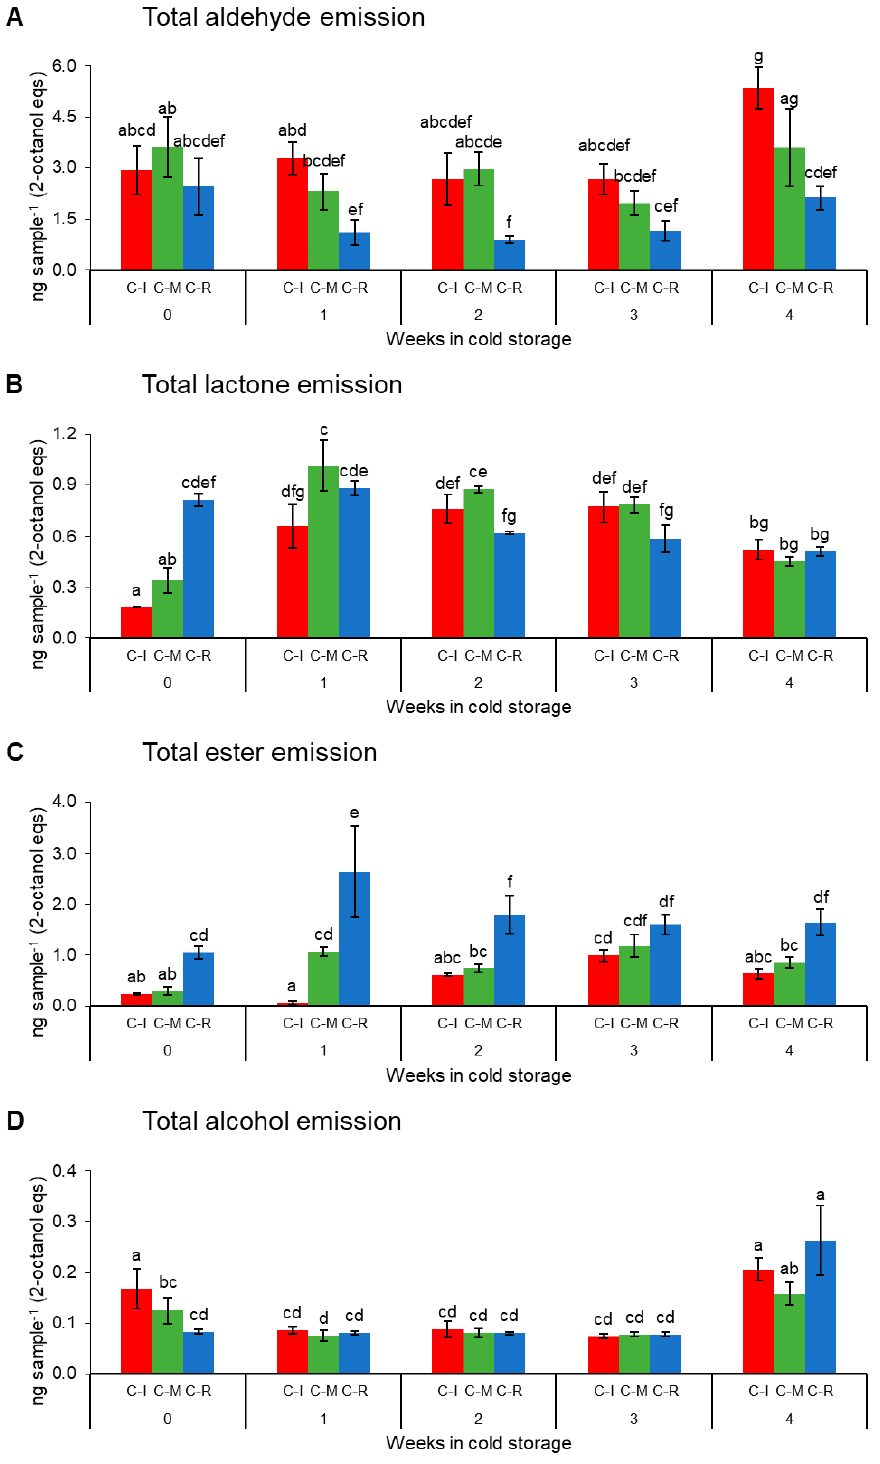
Figure 5. Emission of volatile compounds (grouped by chemical family and expressed as 2-octanol equivalents) from fruit samples collected at different maturity stages (C-I: immature; C-M: commercially mature; C-R: ripe), subjected to cold storage for 0-4 weeks, and measured after a 6-day shelf-life at room temperature. For each chemical family ( A : aldehyde; B : lactone; C : ester; D : alcohol), bars marked with different letters are significantly ( p < 0.05) different according to ANOVA followed by Fisher’s Least Significant Difference